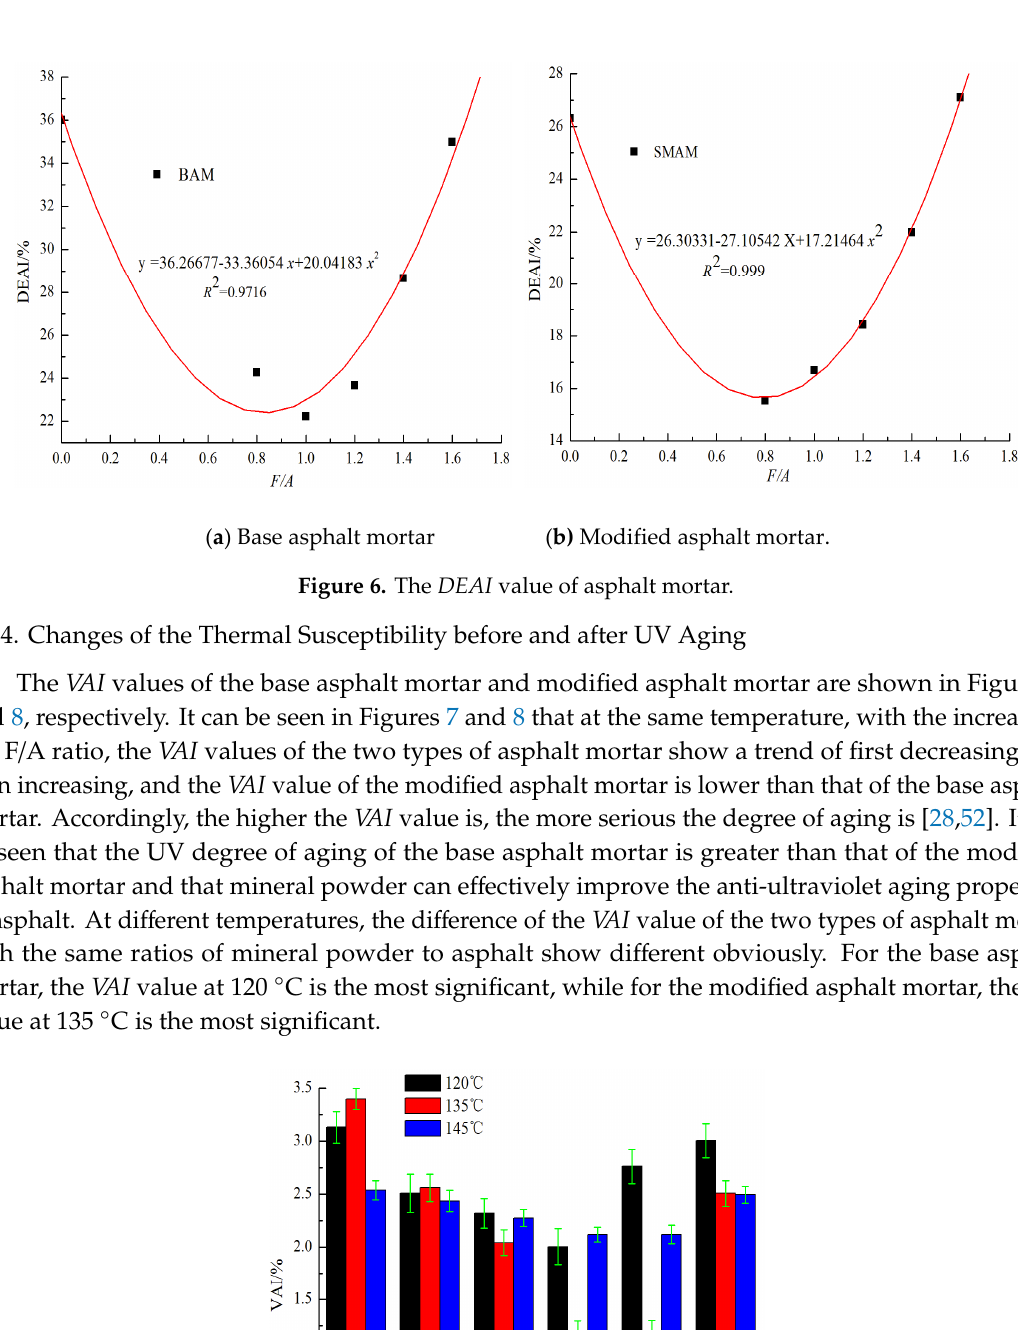
Figure 8. VAI value of modified asphalt mortar. According to Equation (1), the viscous-flow activation energy ( △ E η ) before and after UV aging of the asphalt mortar are calculated, and the relevant calculation results are shown in Figure 9. It can be seen in Figure 9 that before UV aging, the viscous-flow activation energy of the two types of asphalt mortar increases with the increase in the mineral powder content. Compared with the results before UV aging, the △ E η value of the matrix asphalt mortar increases, the △ E η value of modified asphalt mortar decreases, and the △ E η value of the modified asphalt mortar is lower than that of the matrix asphalt mortar. The △ E η is closely related to the temperature stability of a material. The higher the viscosity activation energy is, the lower the temperature sensitivity is [22,28,52]. It can be seen that the temperature sensitivity of the matrix asphalt mortar is reduced by UV irradiation, which is mainly due to the interaction between the asphalt components. Compared with the matrix asphalt, the viscosity activation energy of the modified asphalt decreased after UV aging. This result may occur due to the degradation of the SBS under UV irradiation, which weakens the interaction between the asphalt and the polymer [36,38,55].